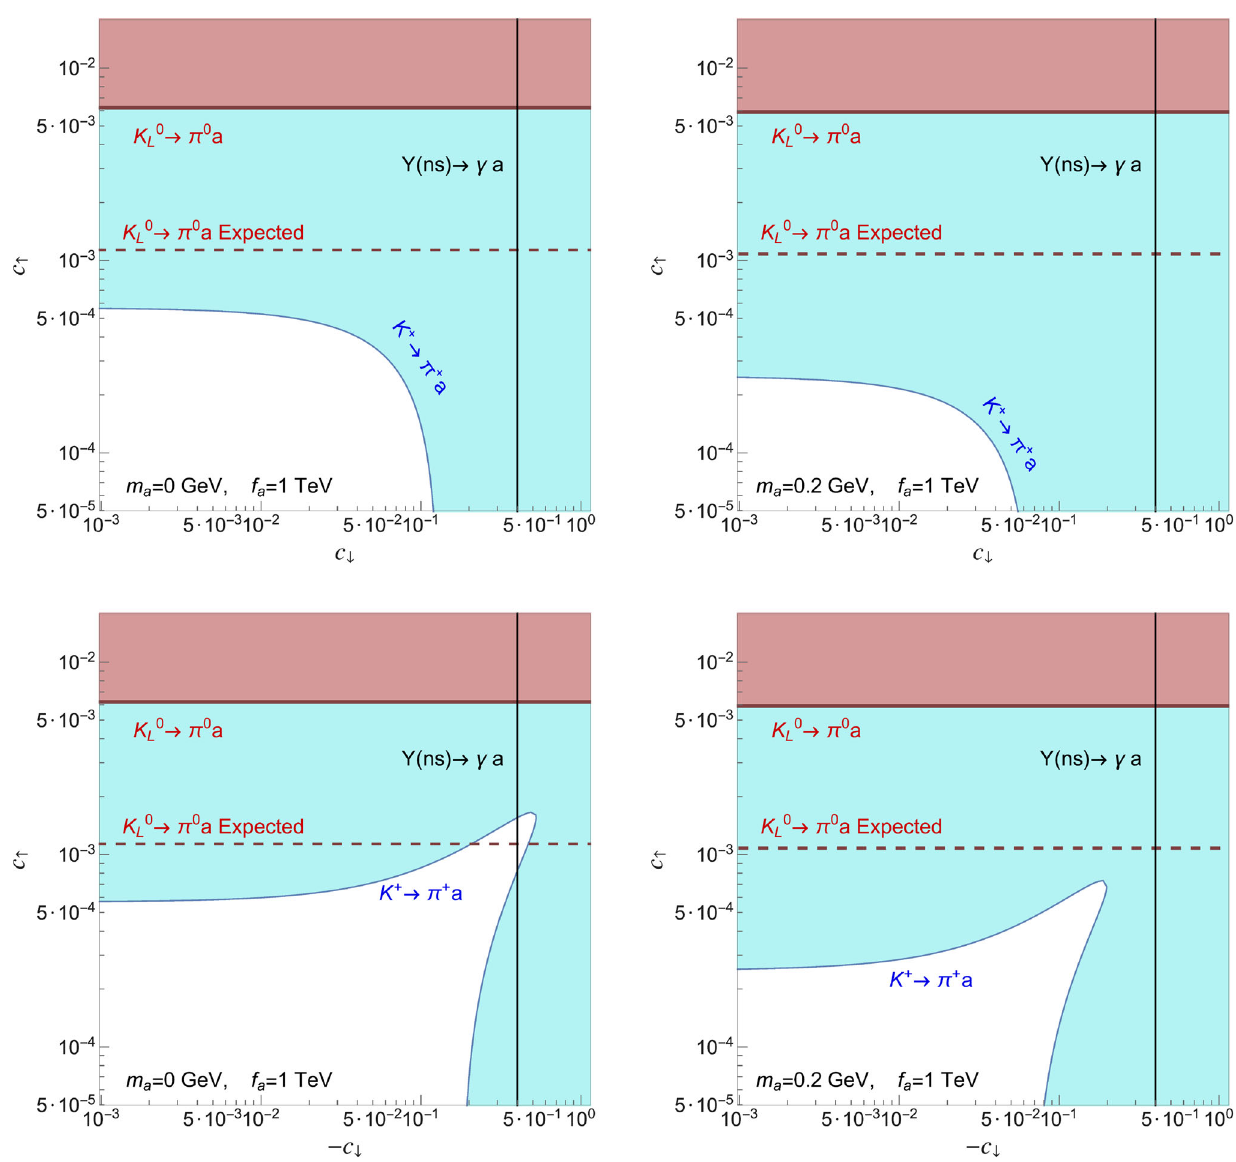
Fig. 6 Excluded parameter regions for universal ALP-up and down quark couplings c ↑ and c ↓ derived from NA62 (cyan) and KOTO (pink and dashed pink line) and Y ( ns ) → γ a (full vertical black line) exper-